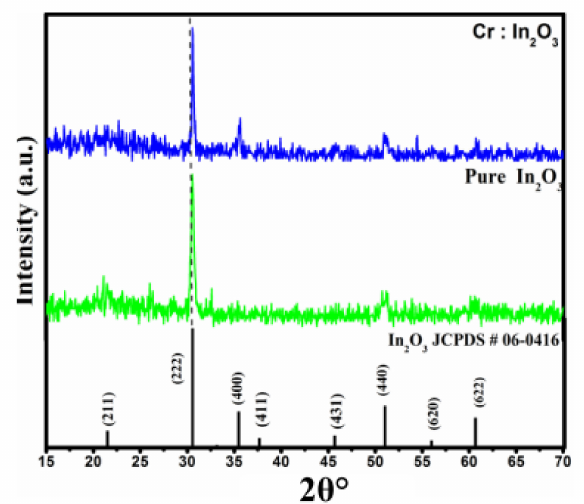
Figure 1. XRD patterns of pure In 2 O 3 and Cr doped In 2 O 3 thin films with a standard JCPDS file